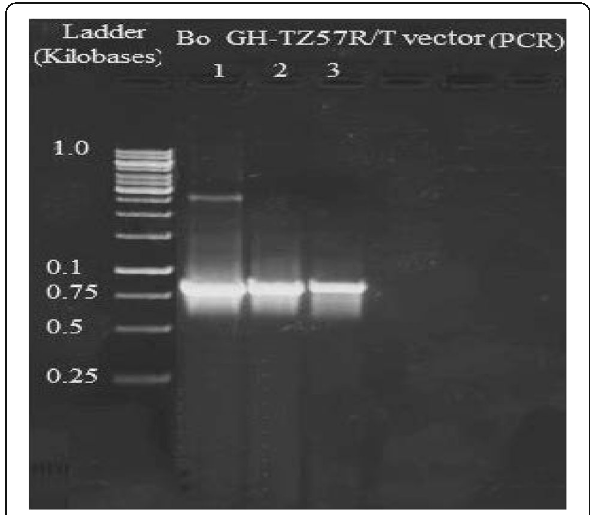
Fig. 4 PCR electrophoresis of Bo_GH-TZ57R/T